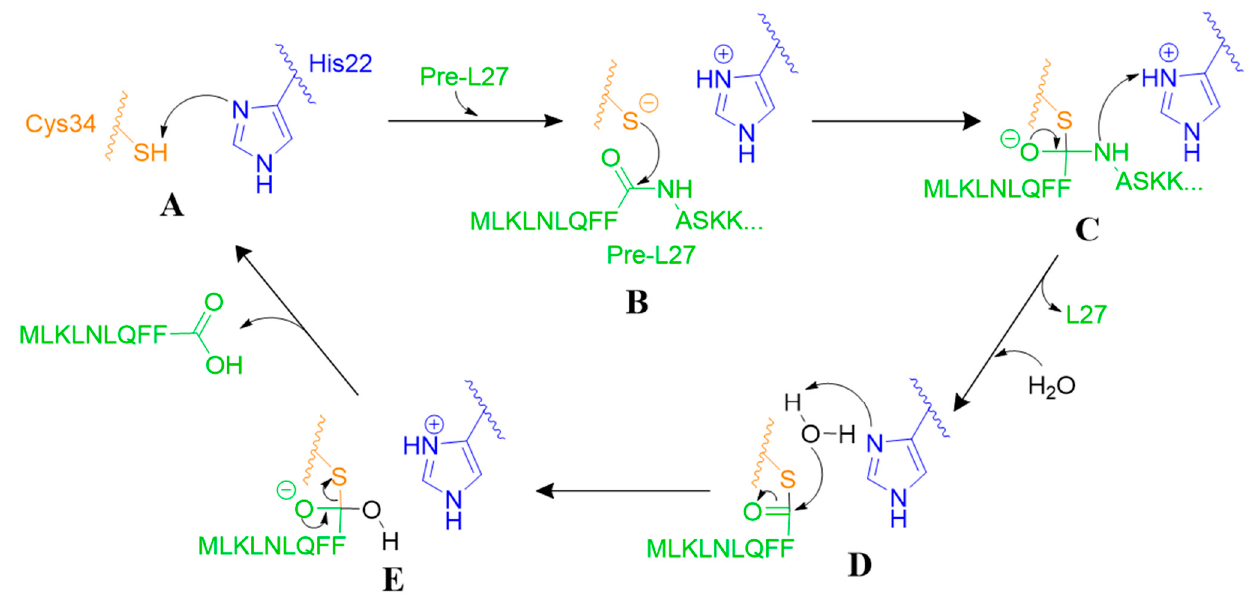
Figure 3. Mechanism of Sa Prp proteolysis of long L27 (green) via a canonical cysteine protease catalytic dyad comprising Cys34 (orange) and His22 (blue). ( A ). Initiation via deprotonation of cysteine by the histidine. ( B ). Cystine thiolate acts as a nucleophile to attack the carbonyl carbon of the amide. ( C ). Oxyanion tetrahedral intermediate breaks down. ( D ). Intermediate thioester is attacked by water. ( E ). Cleavage is completed and product released.